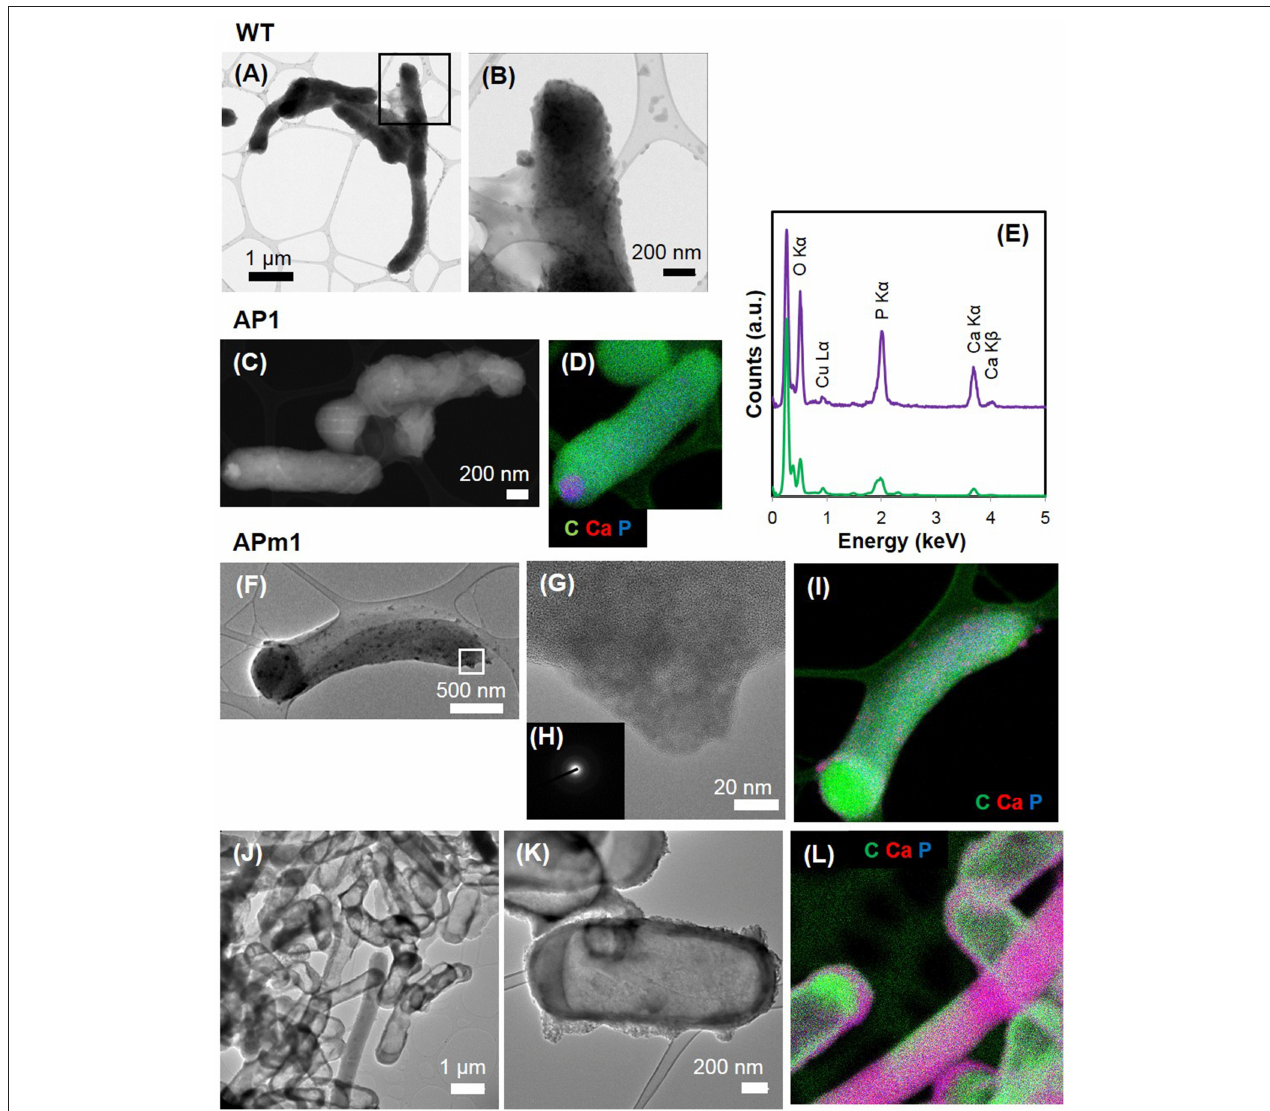
FIGURE 3 | TEM and STEM images of WT, AP1, and APm1 E. coli during the calcification experiments. (A,B) WT E. coli after 1 week in the calcification medium. (B) is a close-up of the area depicted by a square on (A) . (C,D) AP1 after 6 h in the calcification medium. (C) STEM image. (D) EDXS map of C (in green), Ca (in red), and P (in blue), showing that the intracellular dense grains contain Ca and P. (E) EDXS spectrum obtained on the Ca and P-rich grain (in purple) and bacterium (in green) on (D) . The tall peak on the left of the spectrum corresponds to the C K α x-ray emission line. Cu comes from the grid on which the sample was deposited. (F–L) APm1 after 6 and 24 h in the calcification medium, respectively. (G) is a close-up of a patch at the surface of a cell at 6 h, depicted by a rectangle in (F) . (H) Diffuse electron diffraction pattern obtained on the grain on (G) . (I) EDXS maps of C (in green), Ca (in red), and P (in blue) at 6 h. (J,K) Show fully encrusted APm1 cells. (L) EDXS maps of C (in green), Ca (in red), and P (in blue). Some bacteria are both encrusted and filled by